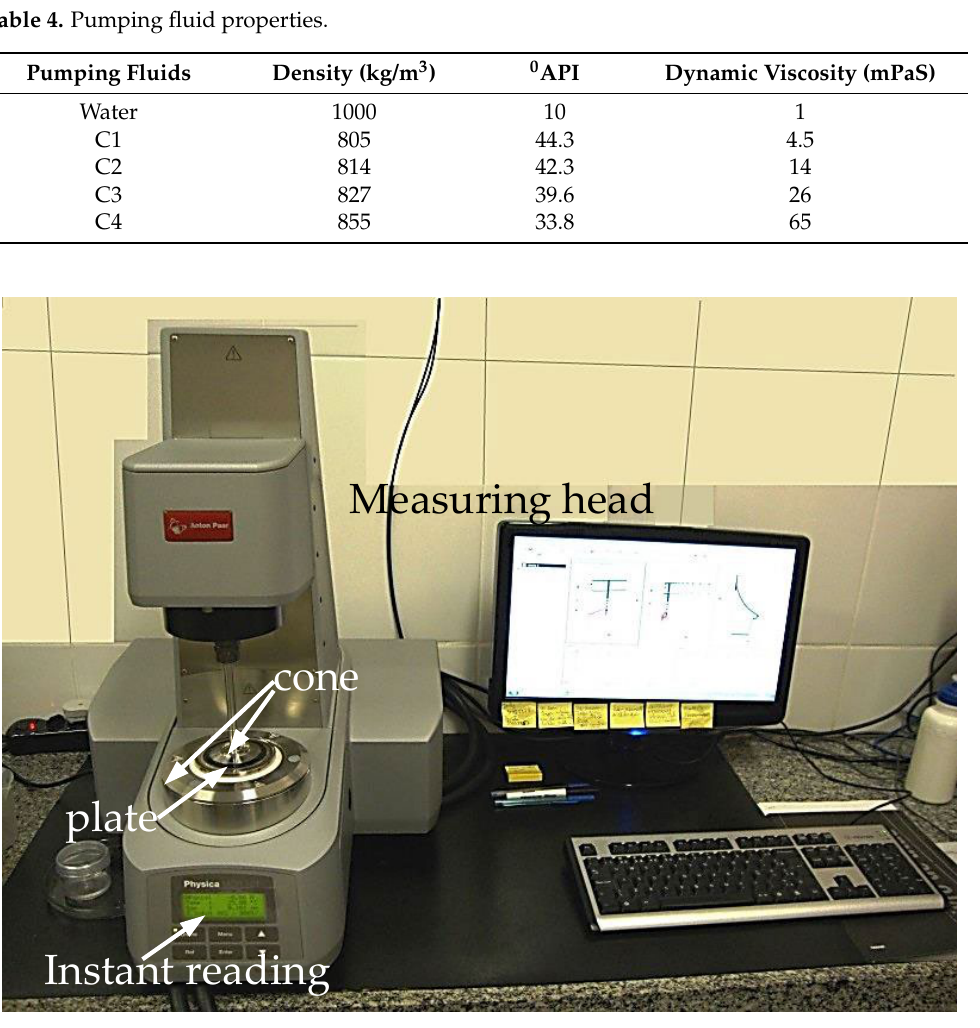
( a ) ( b ) Figure 7. Rheological fluid properties: ( a ) dynamic viscosity versus shear rate and ( b ) shear stress versus shear rate. 0